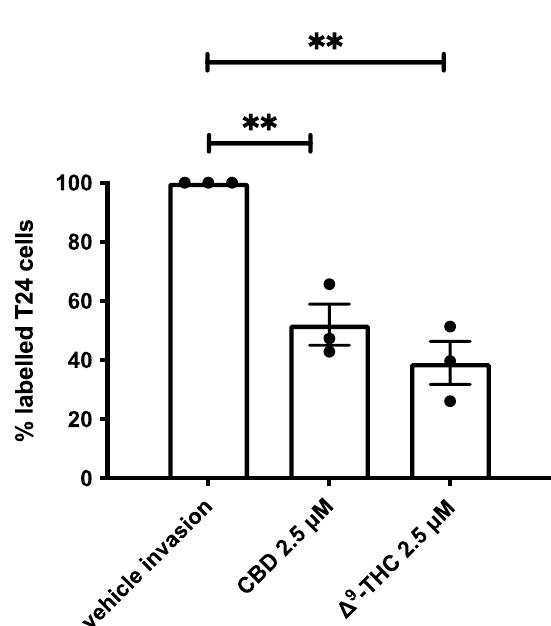
Fig. 4 Effects of cannabinoids on invasion. Histogram summarizing Matrigel invasion assays using T24 cells in the presence of either the vehicle control, Δ. 9 -tetrahydrocannabinol, or cannabidiol. Results represent the means SEM of 3 experiments. * p < 0.05, *** p < ±